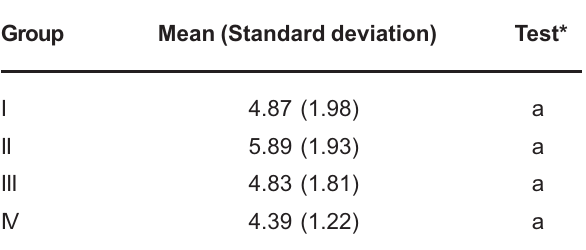
** All values were statistically equivalent